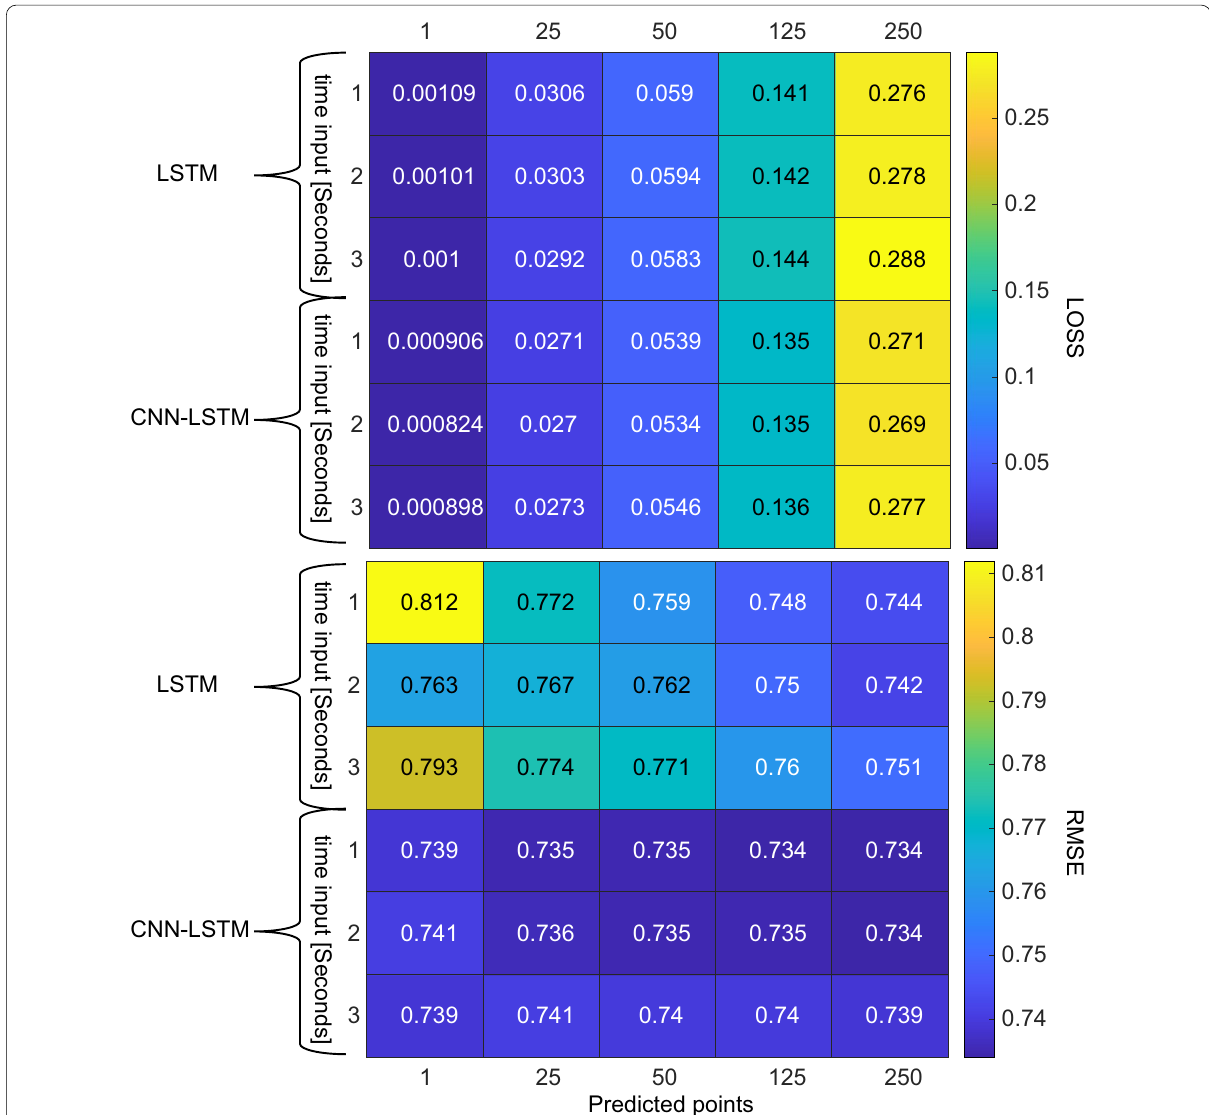
Fig. 8 Validation loss (top) and test set RMSE (bottom) of each predicted points (column) vs time input (row) of the LSTM and CNN-LSTM models trained with data set 2